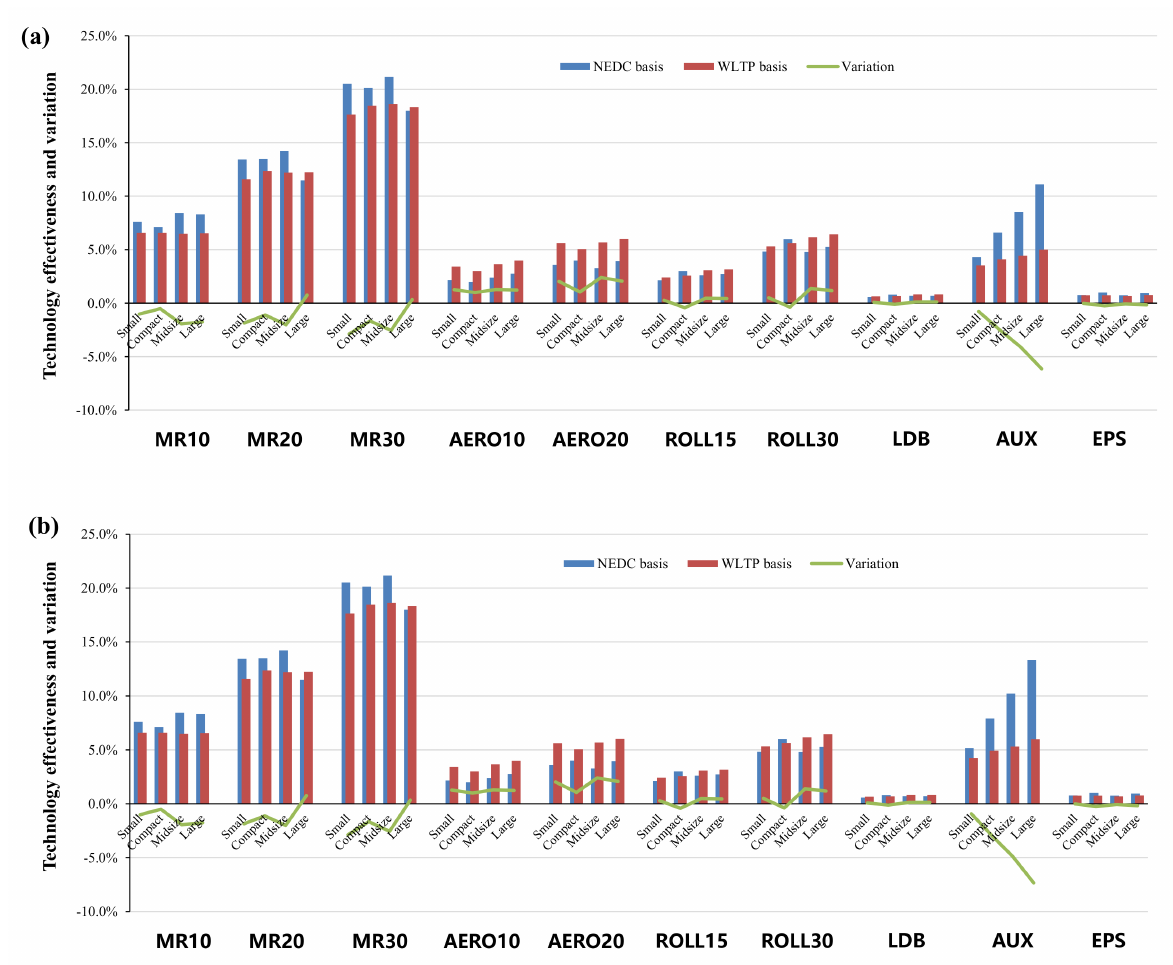
Figure 8. ( a , b ): Comparisons of vehicle and accessory technologies in 2025 and 2030. Notes. (1) MR10, MR20, and MR30 represent 10%, 20%, and 30% mass reduction from the whole vehicle respectively. (2) AERO10 and AERO20 represent 10% and 20% reduction in air resistance coefficient respectively. (3) ROLL15 and ROLL30 represent 15% and 30% reduction in rolling resistance